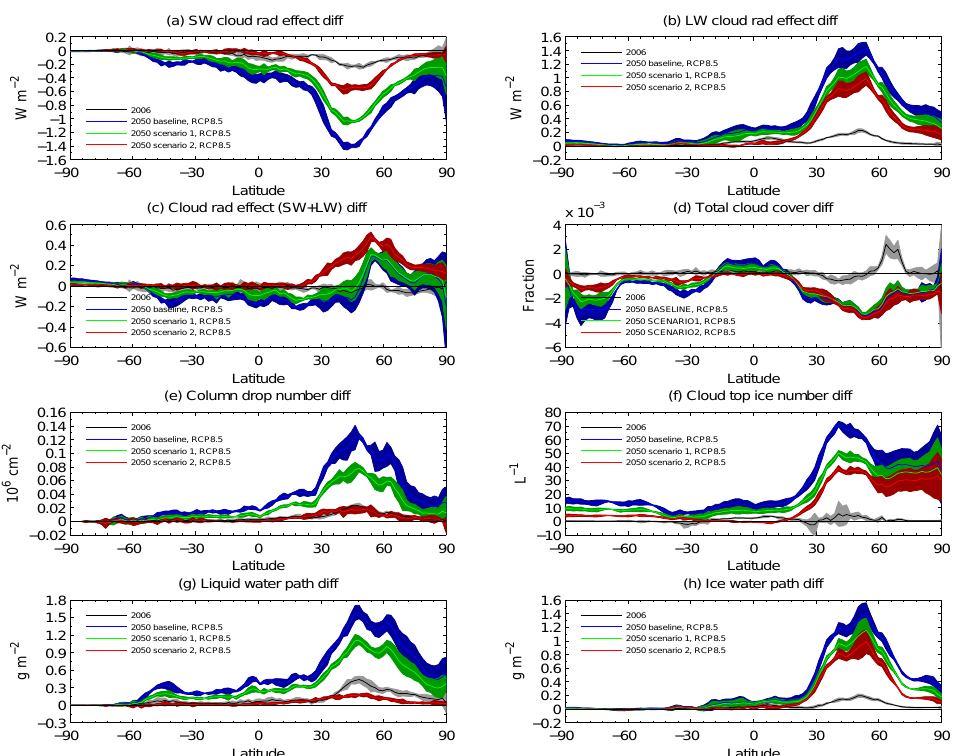
Figure 5. Similar as in Fig. 4, zonally averaged aviation impact due to contrail cirrus and aviation aerosols based on emissions in 2006 and the present background meteorology, three future emissions scenarios in 2050 (baseline, scenarios 1 and 2) and the background meteorology in 2050 by RCP8.5.